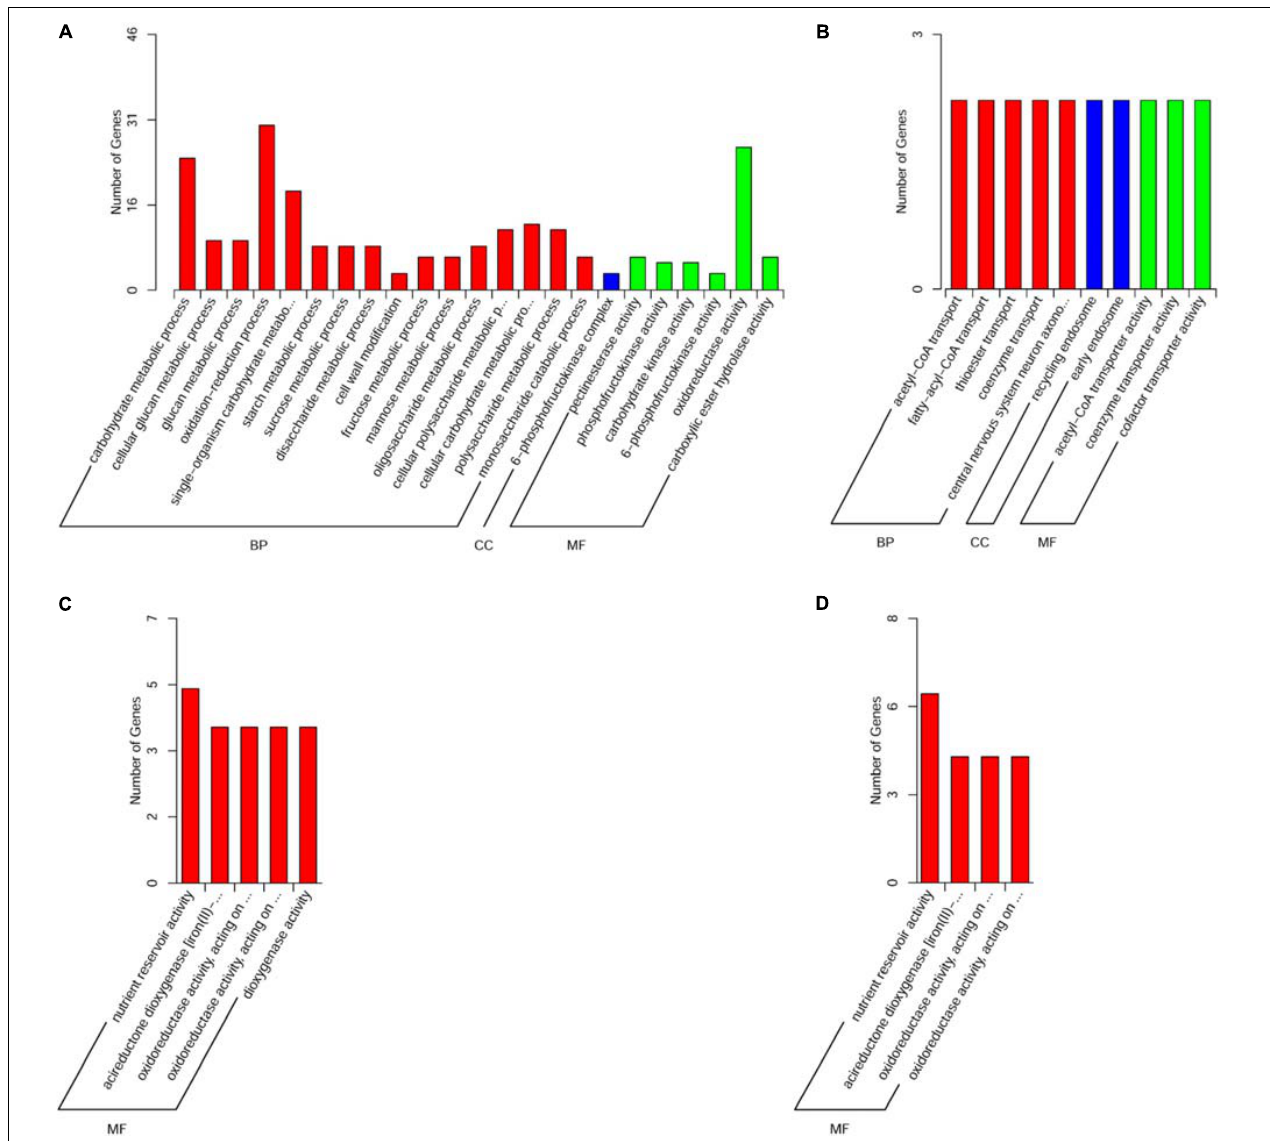
FIGURE 4 | Gene ontology functional classification of (A) significantly upregulated genes in the muscle, (B) significantly downregulated genes in the muscle, (C) significantly upregulated genes in the liver, and (D) significantly upregulated genes in the brain. BP, biological process; CC, cellular component; MF, molecular